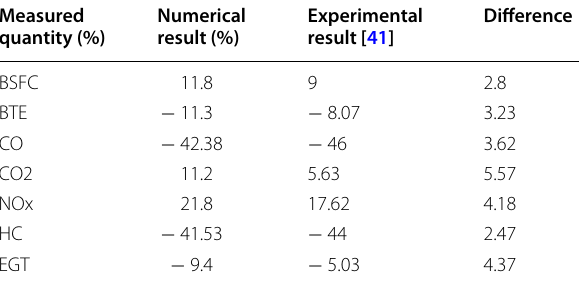
Table 9 Rate of change in the results for biodiesel